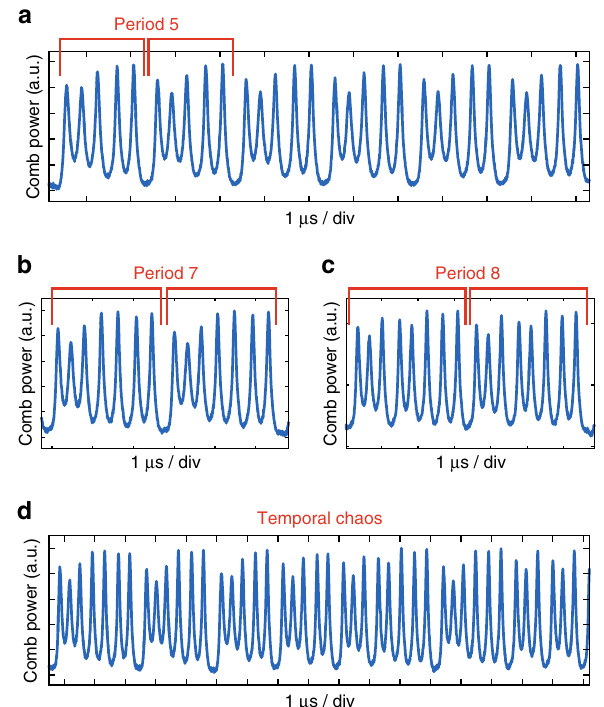
Fig. 7 Experimental observation of high periodicity breathing and temporal chaos. The periodicity is assessed when the pattern is repeated at least d Irregular breathing, no clear periodicity can be